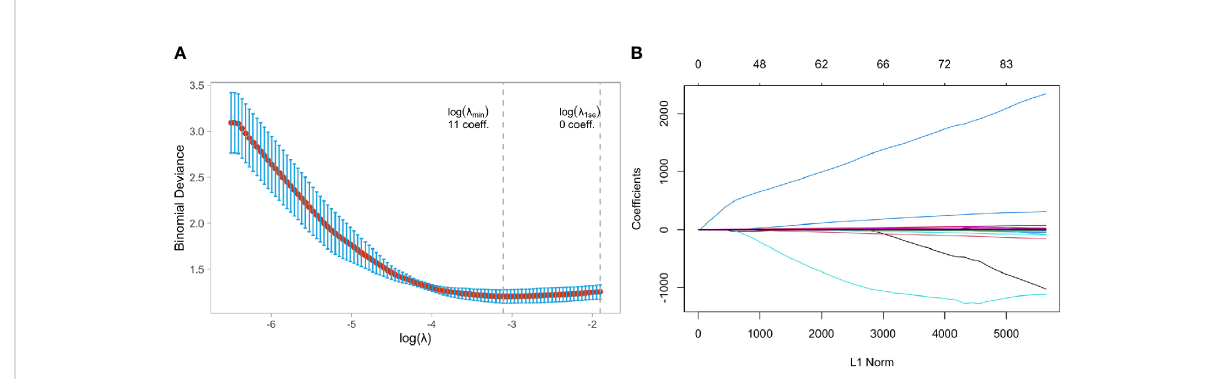
FIGURE 5 Feature selection using the least absolute shrinkage and selection operator (LASSO) binary logistic regression model in HER2-overexpressed and Non-HER2-overexpressed group. (A) Tuning parameter selection in the LASSO model used 5-fold cross-validation via minimum criteria, (B) LASSO coef fi cient pro fi les of the baseline features.